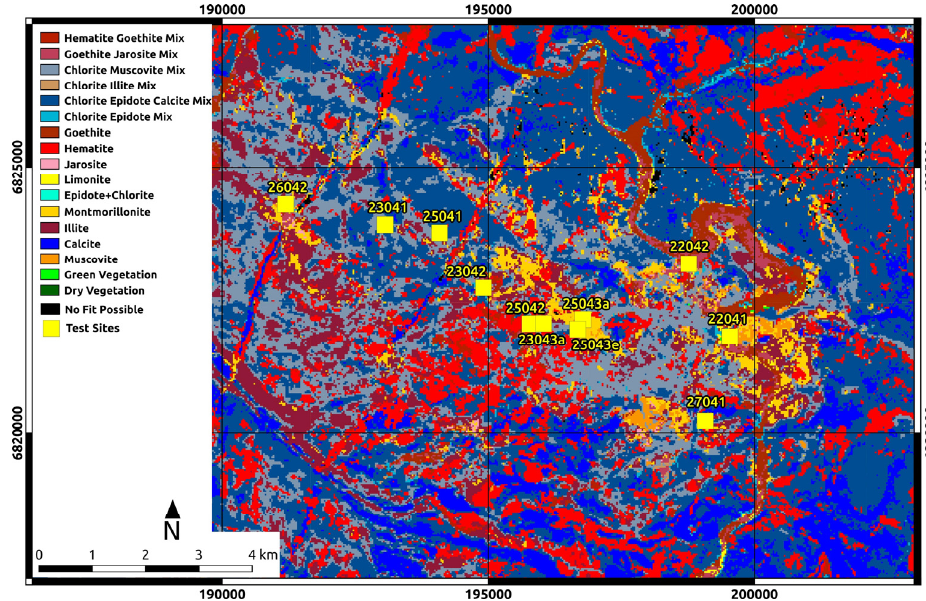
Figure 17. EnGeoMAP 2.0 best fit material map, using sensor dependent absorption depth thresholding, using the entries of the USGS digital spectral library [12]. Linear combinations of their entries labeled with as “Mix” follow the endmember combinations derived from Minnit [17].